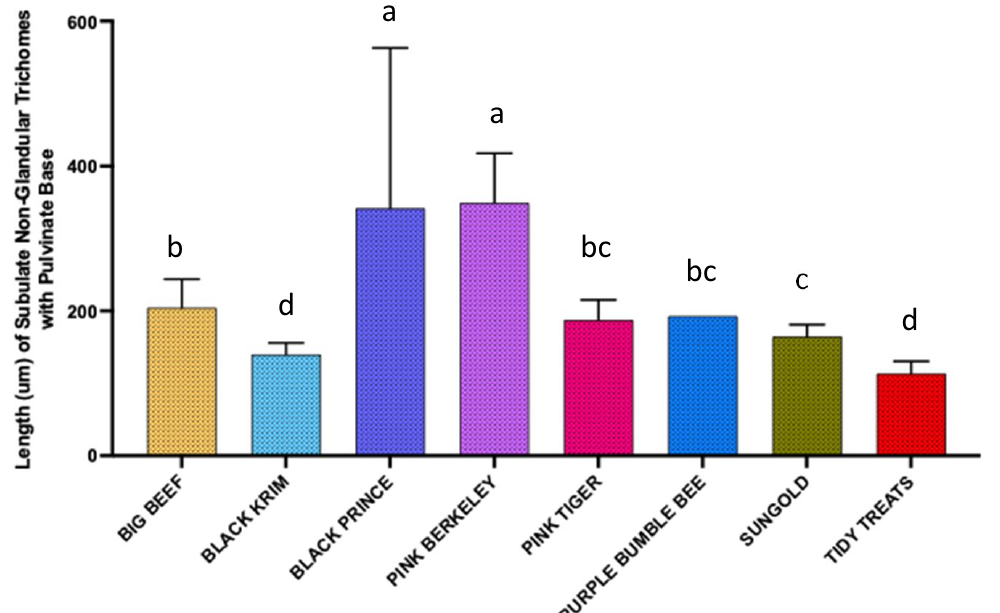
Fig. 13 The comparison of length (µm) of third non-glandular trichome (subulate non-glandular hair with pulvinate base and pedestal) for ten varieties of